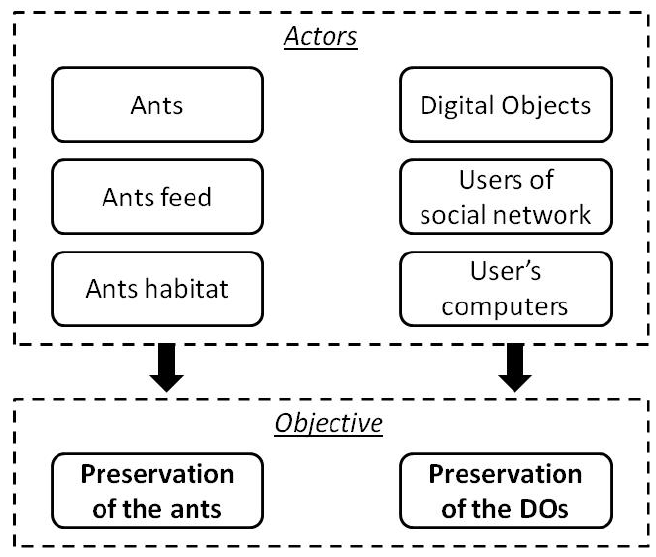
Figure 2. Ant colony model for digital